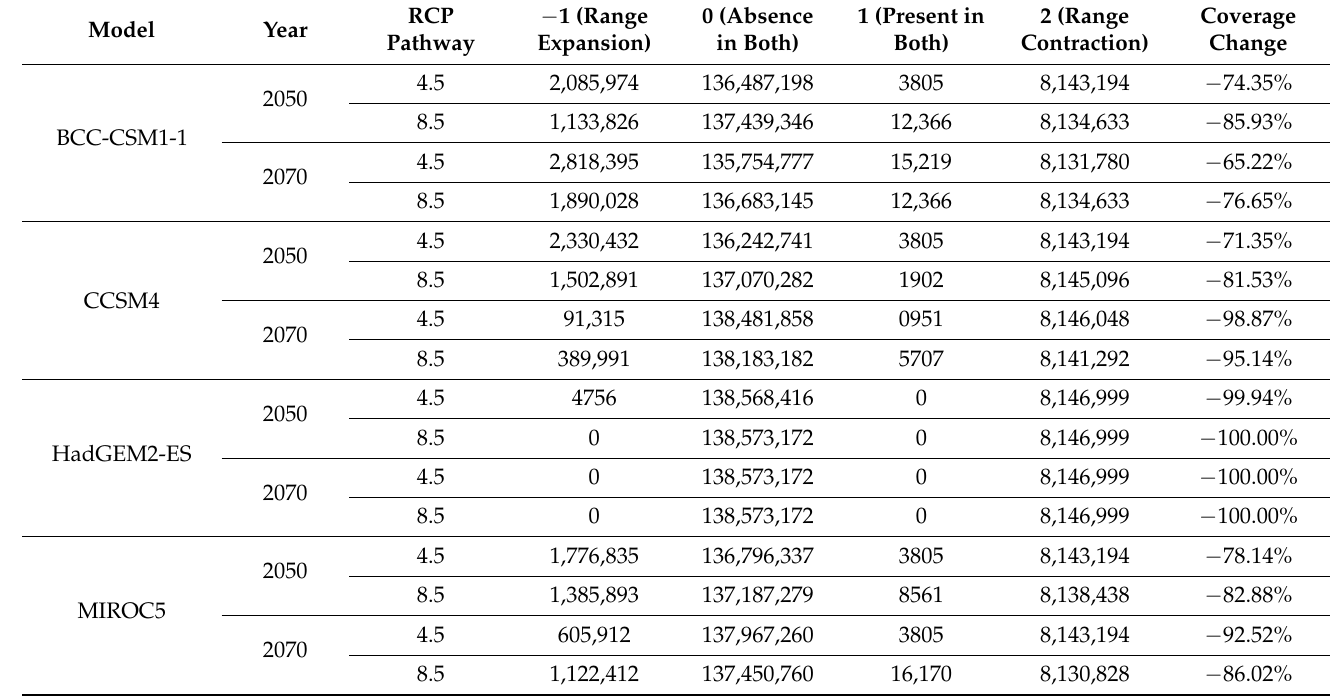
Table 2. Change in the coverage (km 2 ) of suitable niches of D. hatagirea in response to various climate change scenarios.